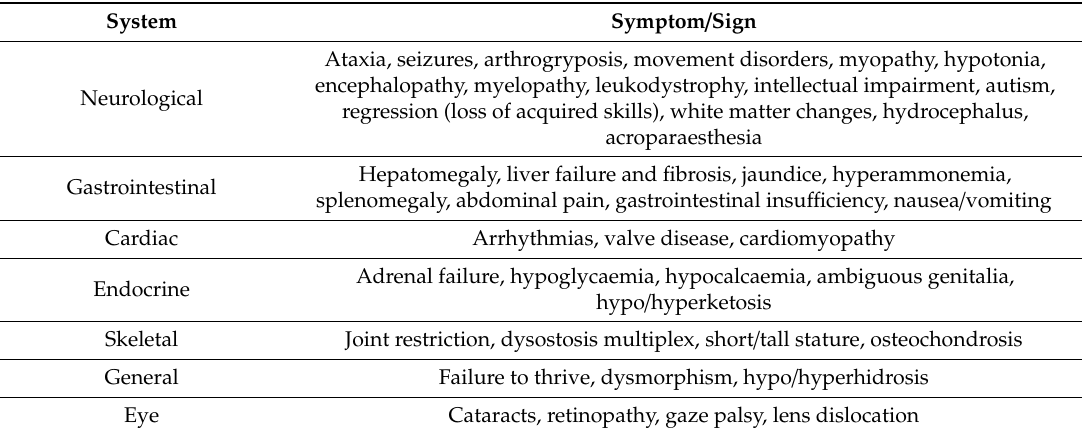
Table 1. Main clinical manifestations of inborn errors of metabolism